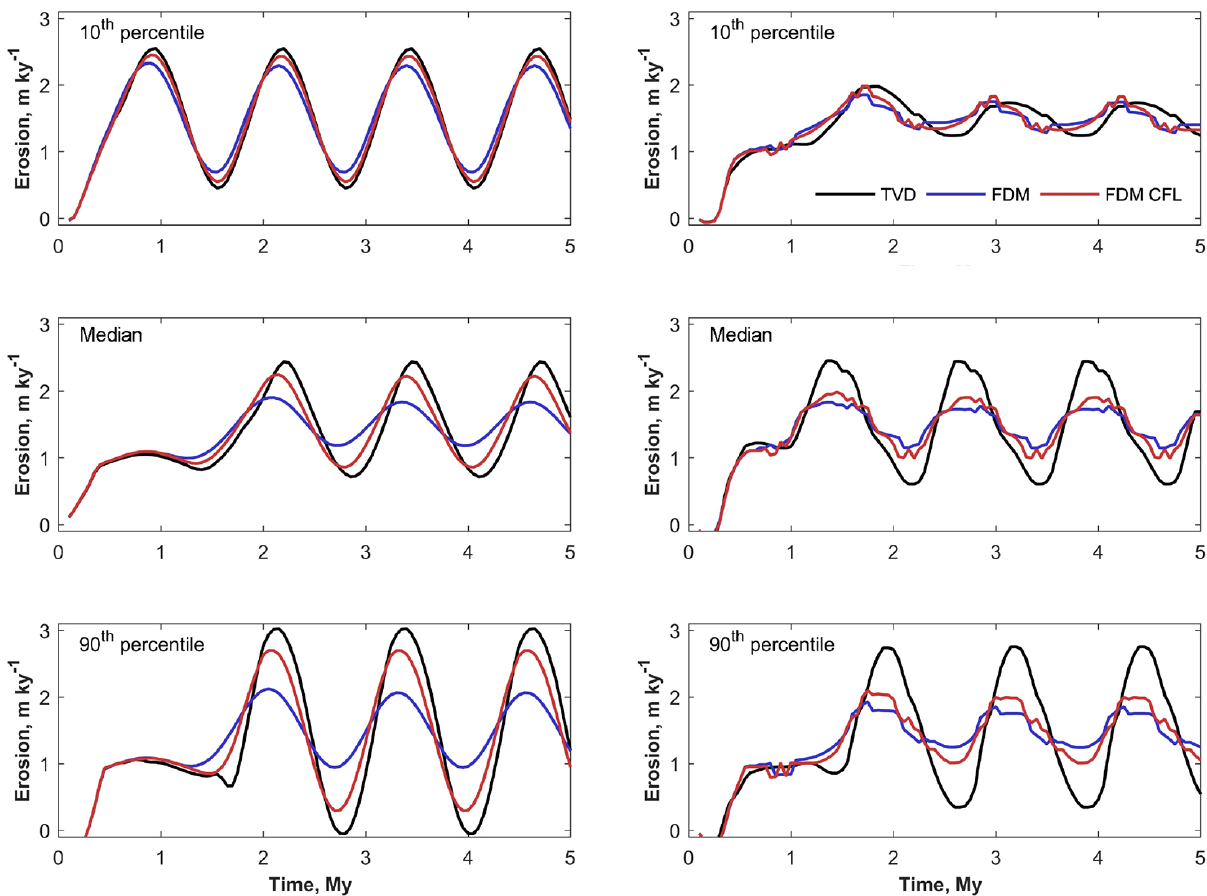
Figure 6. Temporal variation in simulated catchment-wide erosion rates using different numerical methods to simulate river incision. The black lines represent simulations where a flux-limiting TVD-FVM is used, the blue lines represent the first-order accurate implicit FDM without constraints on the time steps, and the red lines represent the first-order accurate FDM with an inner time step calculated with the CFL criterion. (a) Simulations performed at a spatial resolution of 100m. (b) Simulations performed at a spatial resolution of 500m. Here, a median filter with a window of three time steps is applied to the simulated erosion rates to eliminate spikes that might occur at low